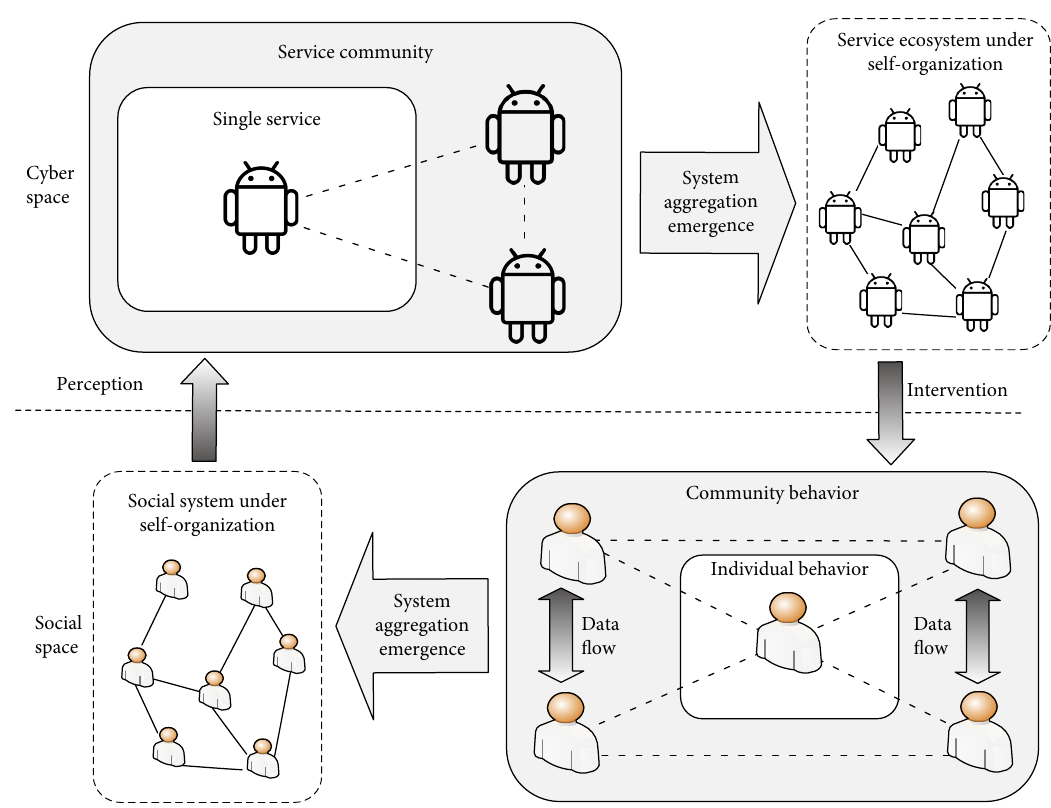
Fig. 14 Loop feedback of the service